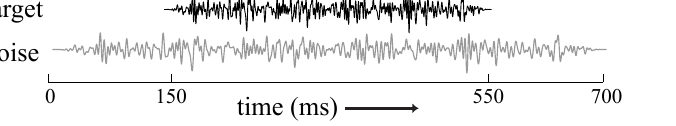
Figure 4. A schematic temporal representation of the stimuli presented in Experiment 2. Details are provided in Section 4.1.